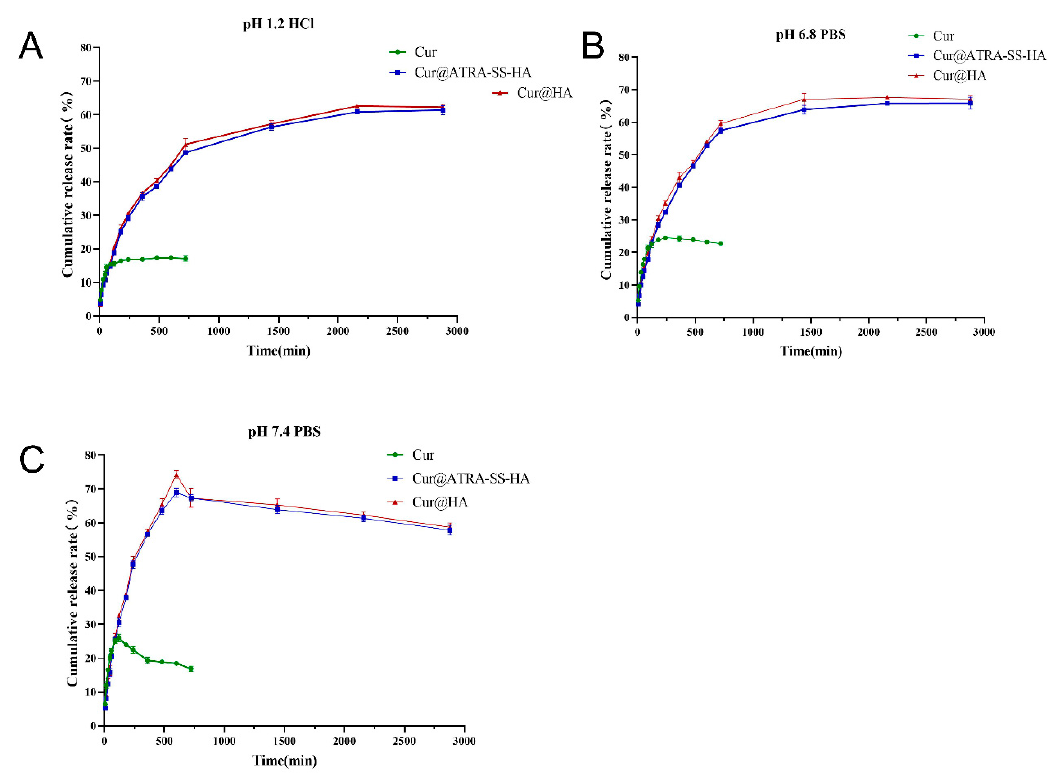
Figure 3. Cumulative release rate of free curcumin, Cur@HA, and Cur@ATRA-SS-HA under pH 1.2 HCl solution ( A ) and pH 6.8&7.4 PBS solution ( B , C ).